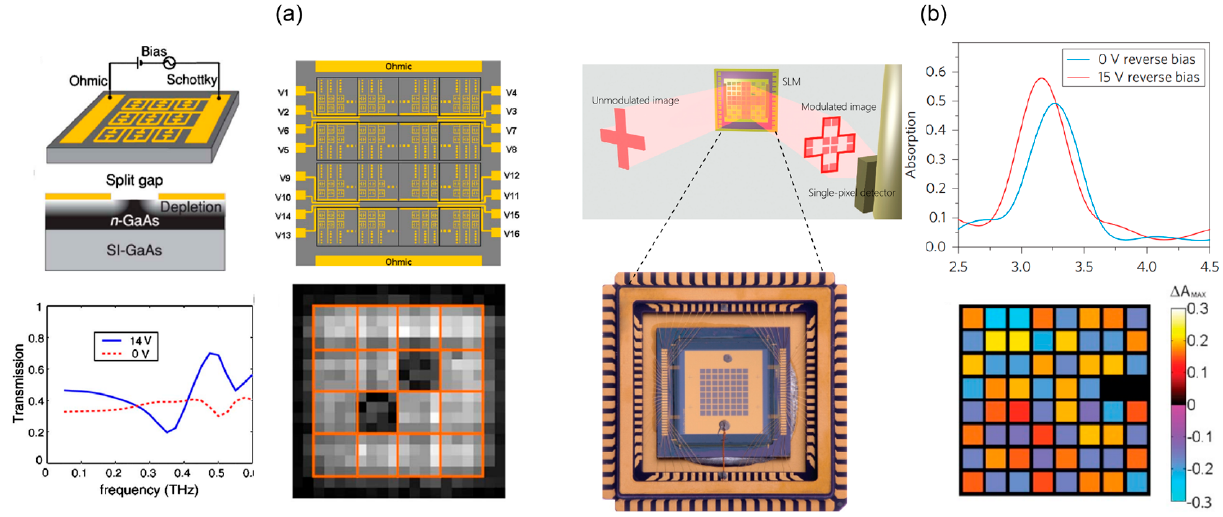
Figure 4. Electrically biased semiconductor THz SLMs. ( a ) Transmissive semiconductor SLM. The geometry of a pixel as a Schottky junction formed by an SRR metamaterial with n-GaAs (top left), the layout of the SLM (top right), the transmission spectra of the pixel with and without electric biasing (bottom left) and a spatial absorption pattern (bottom right). Reproduced with permission from [61]. Copyright 2009 AIP Publishing LLC. ( b ) Reflective semiconductor SLM based on metamaterial absorbers. Modulation of the absorption is done by the bias (top right). Spatial distribution of differential absorption maps (bottom right). Reproduced with permission from [32]. Copyright 2014 Springer Nature.